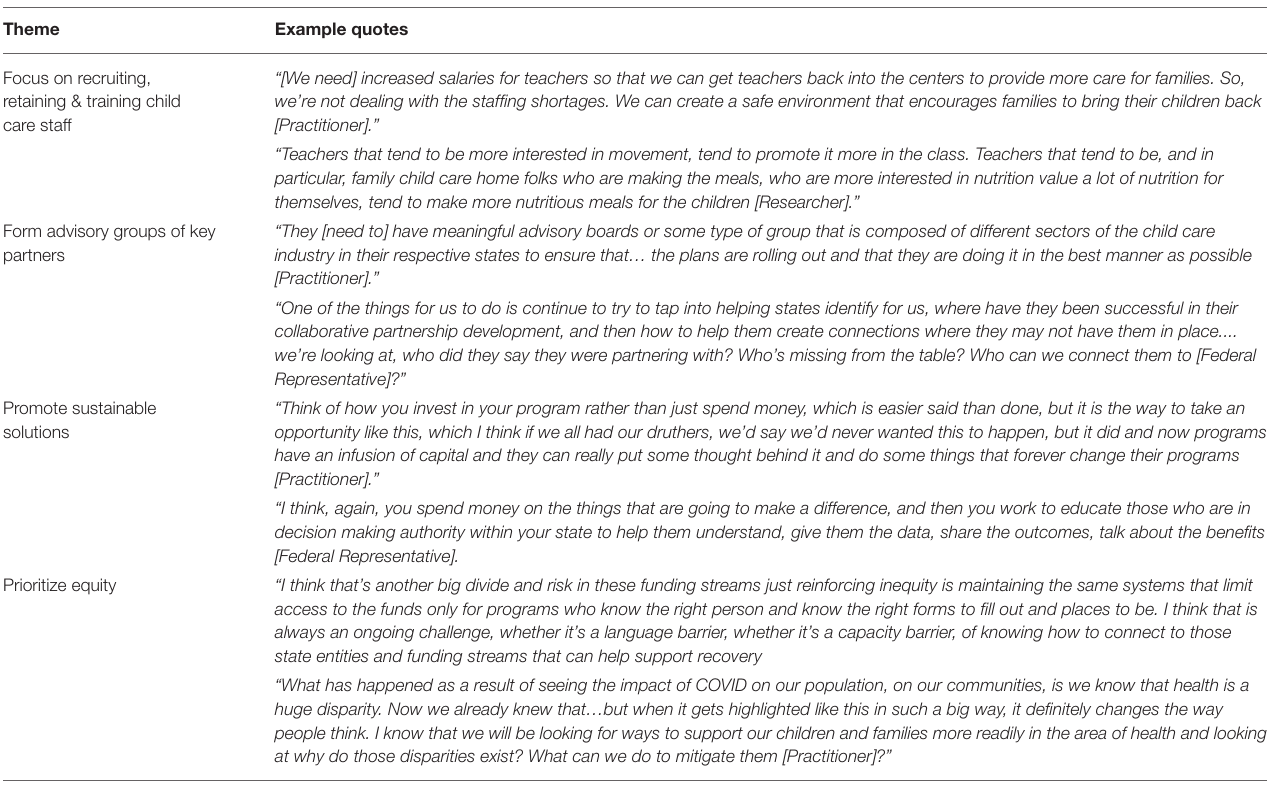
TABLE 4 | Key informant themes and quote snapshot: future directions to help recover from COVID-19. Theme Example